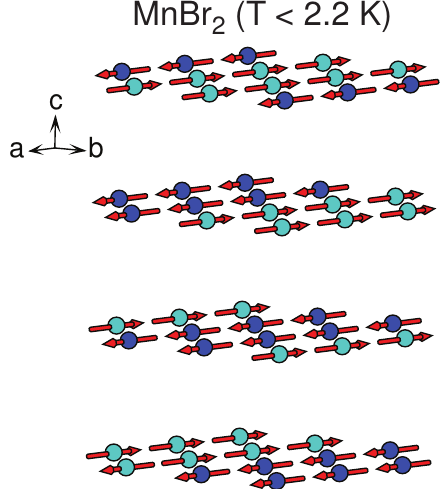
Figure 5. The lowest temperature, commensurate magnetic structure of MnBr 2 . The coordinate system refers to the underlying hexagonal crystal structure. Dark blue is used for Mn atoms with moments along the hexagonal a direction, and light blue for those with moments along - a